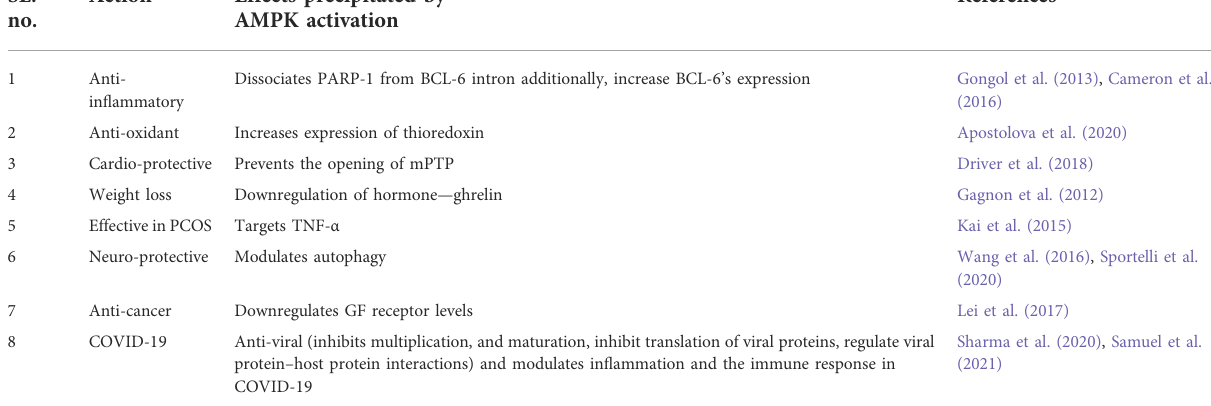
TABLE 2 Actions of metformin through AMPK activation. SL. no.